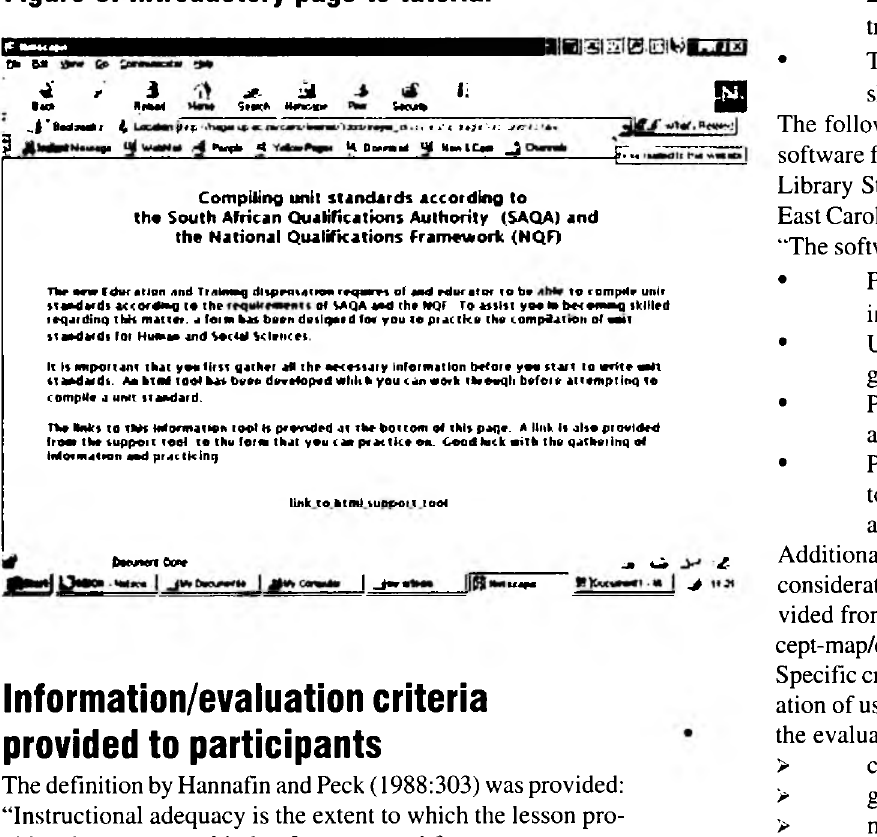
Figure 3: Introductory page to tutorial